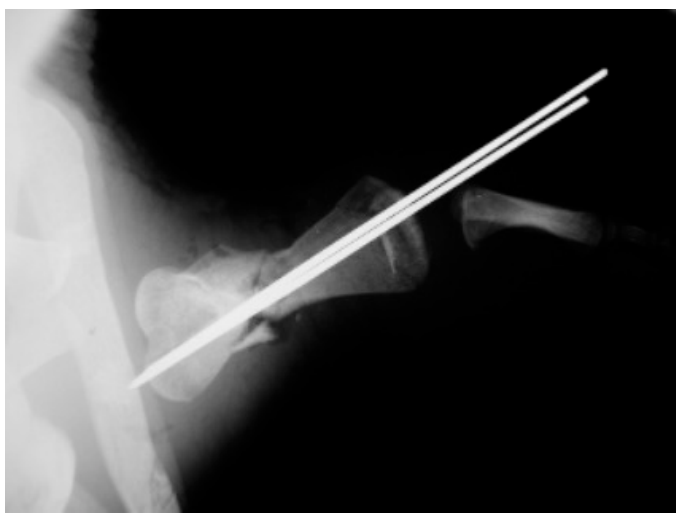
Figure 3. Caudocranial radiograph of the anterior right flipper: postoperative follow up examination.